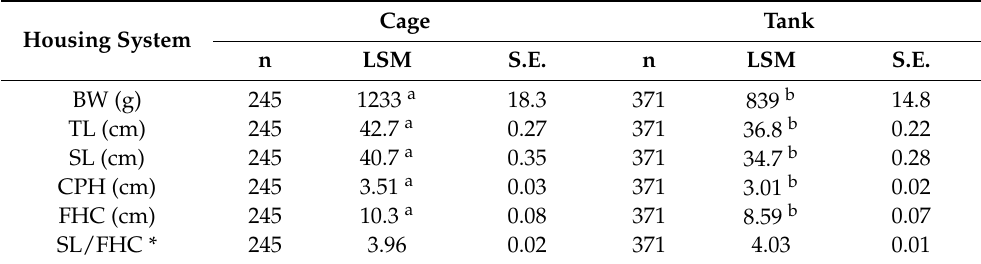
Table 3. Manual growth (body weight and total length) and automatic morphology measurements (by IMAFISH_ML, software) (least square means, LSM, ± standard error, S.E.), for meagre at 549 days post-hatching raised in two different housing